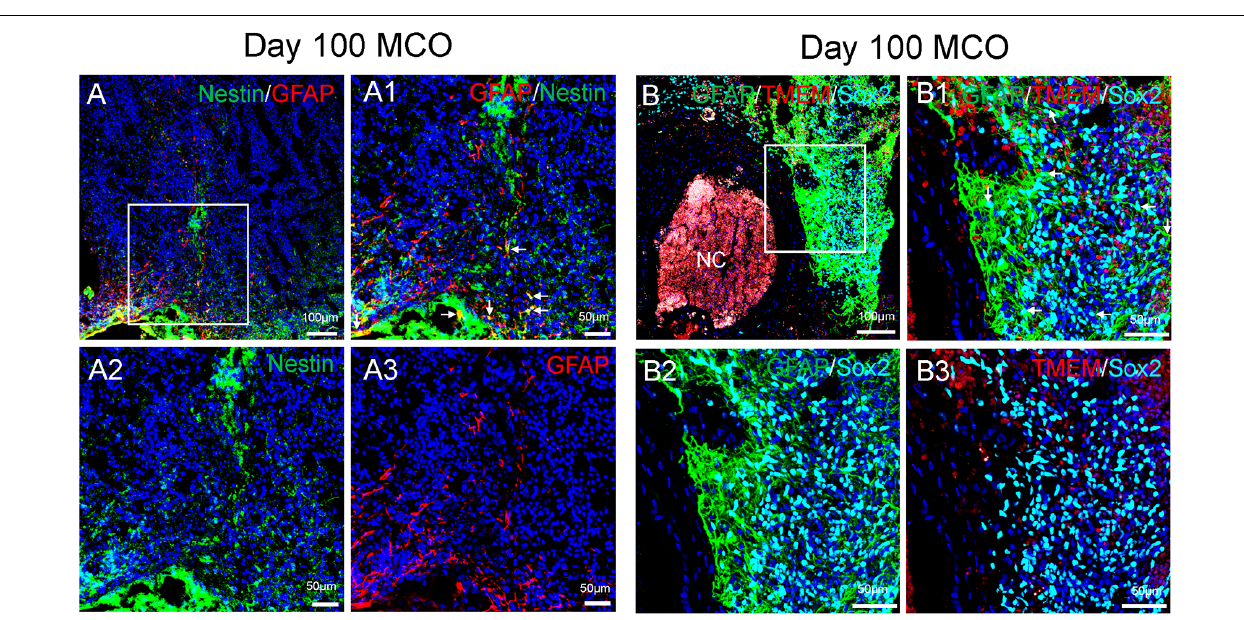
FIGURE 4 | Characterization of cell types in mature MCOs. At day 100 post-EB formation, multiple cell types can be detected by multi-labeled immunofluorescent confocal image analysis with three colors (A) and four colors (B) , including NSCs (Nestin + /GFAP + or Sox2 + /GFAP + , arrows), NPCs (Nestin + or Sox2 + but GFAP - ), astrocytes (GFAP + ), and microglia-like cells (TMEM119 + ). Hoechst was used as a nuclear marker. NC, necrotic center. Panels (A1) and (B1) are the insets from corresponding (A) and (B) . Panels (A2/A3) and (B2/B3) represent split single or double channels, respectively to (A1) and (B1)